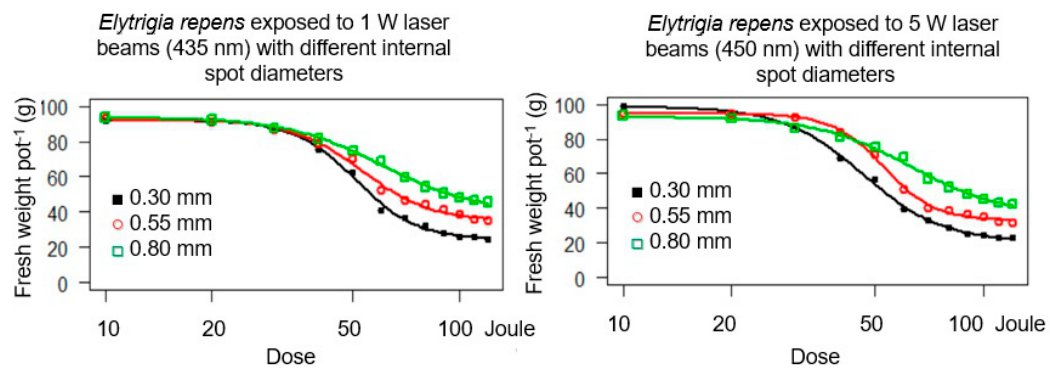
Figure 15. Dose-response curves. ( a ) E. repens plants were exposed to a 1 W laser (435 nm) beams and ( b ) to a 5 W laser (450 nm) beams. Three diameters ( +/ − 0.05 mm) of the internal spot of the laser beams were used: ■ 0.30 mm; ○ 0.55 mm; □ 0.80 mm. The plants were harvest 40 days after laser exposure. Table 2. Estimated parameter and standard errors (SE) of the dose-response models (model 3) for experiments with two laser types and three intervals of internal laser spot diameter corresponding to the curves in Figure 15. The parameter ED 50 is the effective dose (energy in Joule) required to reduce the biomass by 50% between D and C. The parameter b is proportional to the slope at dose x equal to the parameter ED 50 .